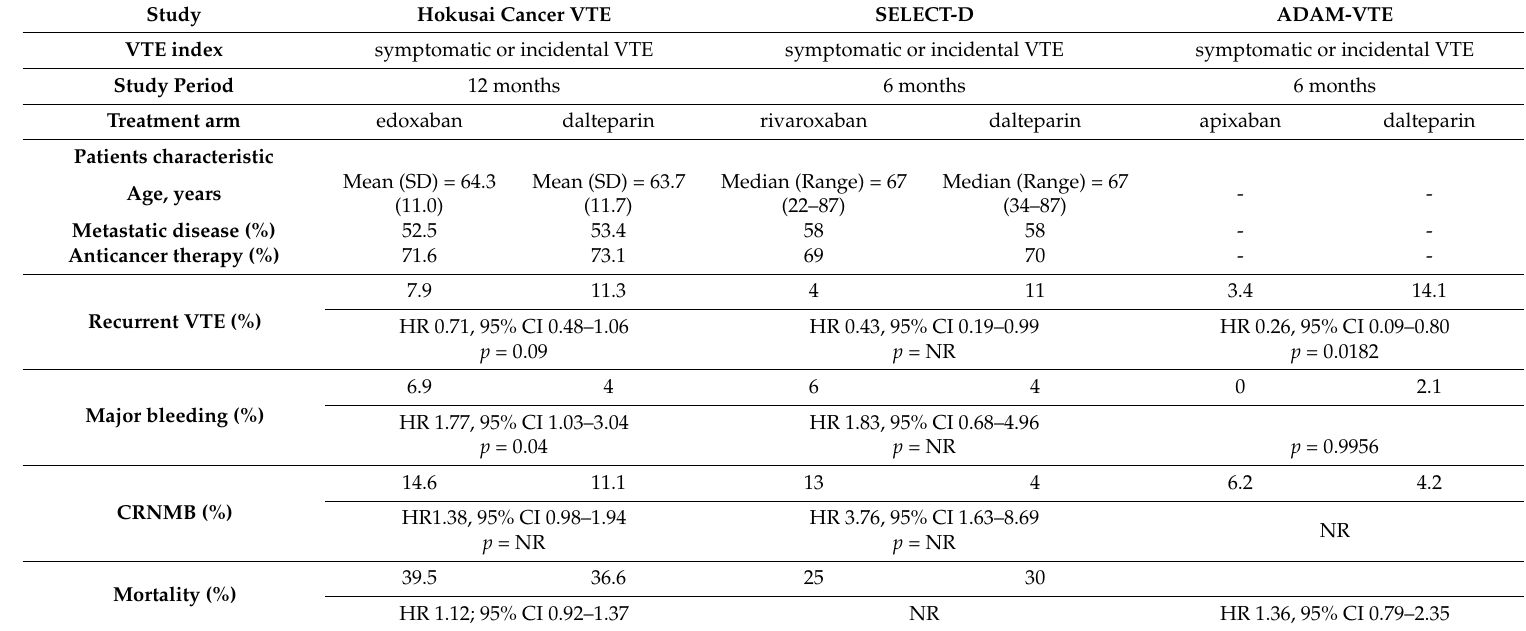
Table 1. Direct oral anticoagulant (DOAC) vs. Low-Molecular-Weight Heparin (LMWH) for Long-term Treatment of VTE in Patients with Cancer: Data from Prospective Randomized